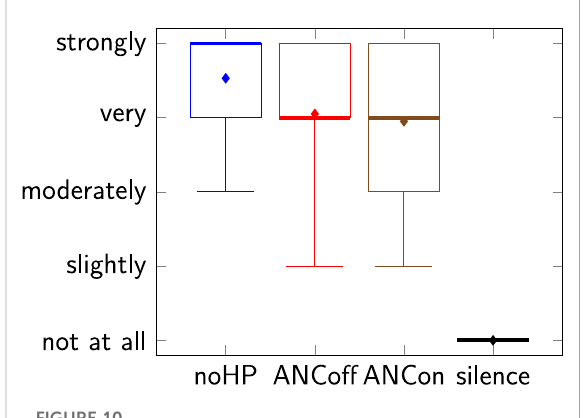
FIGURE 10 Boxplots, showing the long-term disturbance. Only exp. 1.